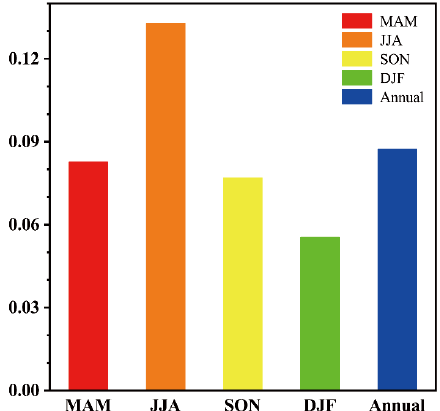
Figure 6. Seasonal and annual average sulfate AOD in 2010 over eastern China (24–43° N, 101–126° E).